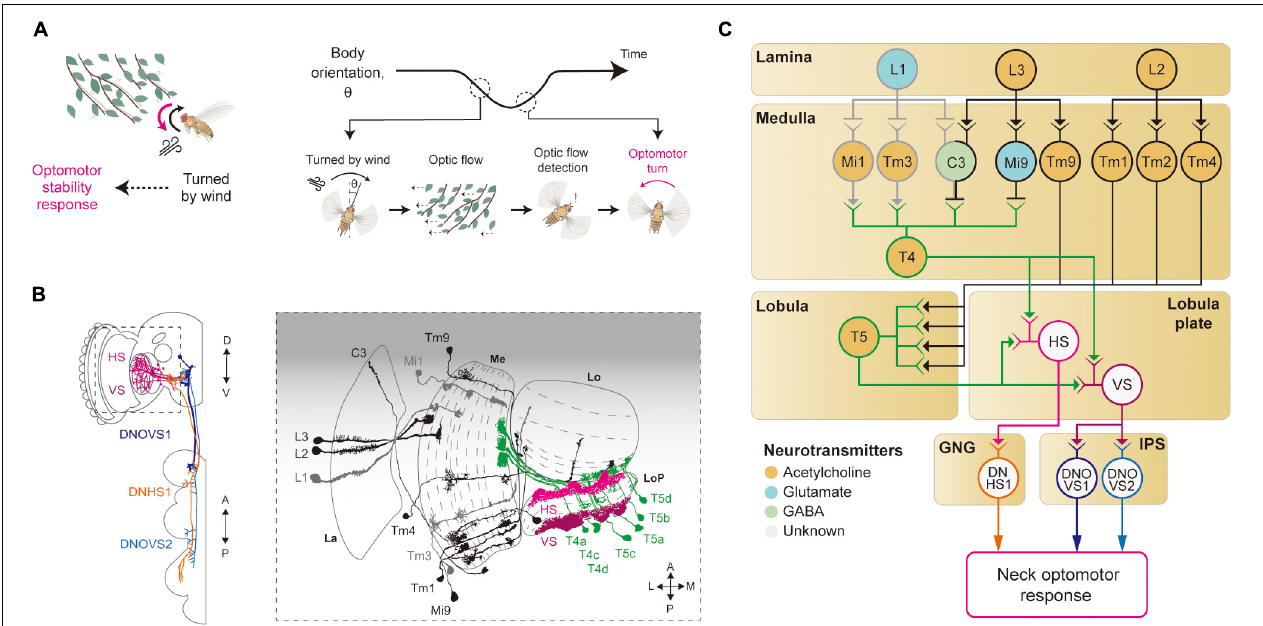
FIGURE 3 | Neural circuits underlying motion detection and optomotor response. (A) When Drosophila is turned by a gust of wind, it recovers its heading immediately. In this reflex, the rotational whole-field visual motion, called optic flow, is detected by the visual system and induces the so-called optomotor response. (B) Schematic illustration of the neurons related to the motion detection and the optomotor response. The graphical depiction is adapted from Suver et al. (2016), Fischbach and Dittrich (1989), and Namiki et al. (2018). The colors of neurons match those in panel (C) . La: lamina, Me: medulla, LoP: lobula plate, Lo: lobula. (C) Schematic diagram of neural circuits related to motion detection and optomotor response. T4 and T5 cells receive visual inputs from light-ON (gray outline) and light-OFF (black outline) pathways and generate motion-sensitive signals with direction sensitivity. Subsequent integration of local motion signals in T4 and T5 cells occurs in the lobula plate tangential neurons, such as HS and VS (pink and purple outlines), to give rise to optic flow signals. These signals are transmitted to descending neurons, such as DNHS1, DNOVS1 and DNOVS2 (orange, dark blue and light blue outlines), leading to the optomotor response. The face color of a circle represents the type of neurotransmitters released by a neuron, and the line color of a circle matches that of the neuron in panel (B) . GNG: gnathal ganglia, IPS: inferior posterior